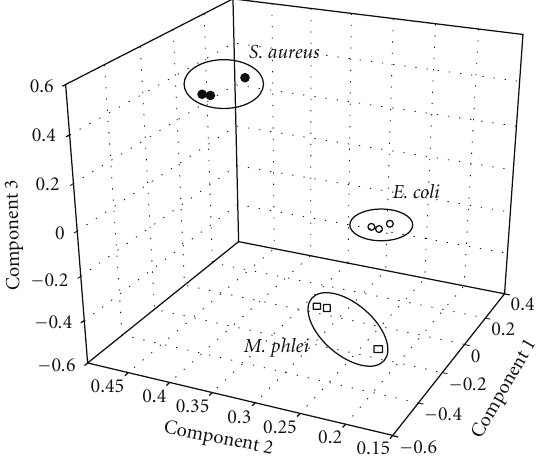
Figure 4: Pattern recognition plot obtained from impedimetric measurements using di ff erent lectins showing that EIS allows classi- fication and distinction among di ff erent types of bacteria. Reprinted from [64], Copyright 2009, with permission from